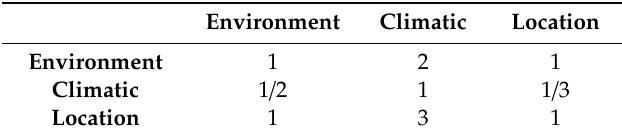
Table 6. Comparison matrix of suitability factor